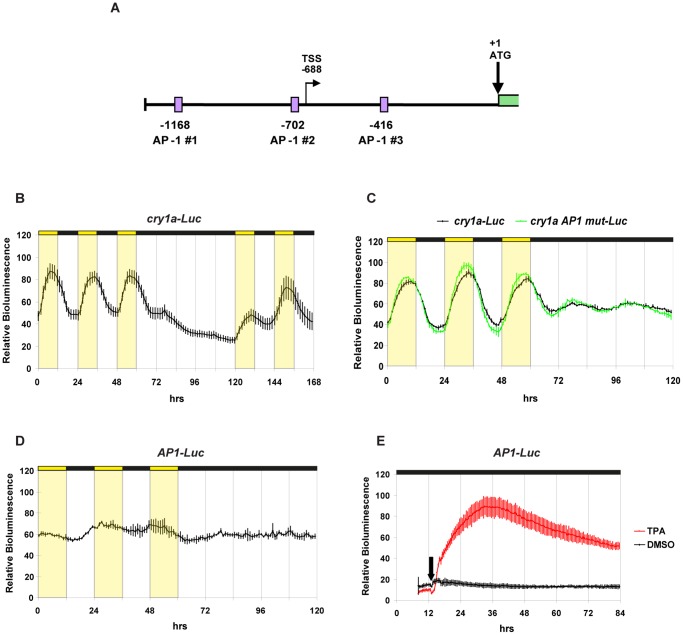
Role of AP-1 enhancer elements in light-induced expression of cry1a.(A) Schematic representation of the 1.3 kb cry1a promoter. The 53 bp exon 1 is indicated by a green rectangle. The transcription start site (TSS) at position −688 bp and the ATG at position +1 bp are indicated. Violet rectangles denote the three AP-1 sites (AP-1 #1 at position −1168 bp, AP-1 #2 at position −702 bp and AP-1 #3 at position −416 bp). (B – E) Representative real time bioluminescence assays of PAC-2 cells transfected with the following constructs (B) cry1a-Luc. (C) cry1a-Luc (black trace) and cry1a AP1 mut -Luc (green trace). (D) AP1-Luc. (E) AP1-Luc in the presence (red trace) or absence (black trace) of 50 ng/ml of the phorbol ester TPA. The black arrow indicates the time of TPA or DMSO-control addition. In each panel relative bioluminescence is plotted on the y-axis and time (hrs) on the x-axis. Each time-point represents the mean of at least four independently transfected wells +/− SD from a single experiment. Each experiment was performed a minimum of three times. Yellow and black bars above each panel represent the light and dark periods, respectively.